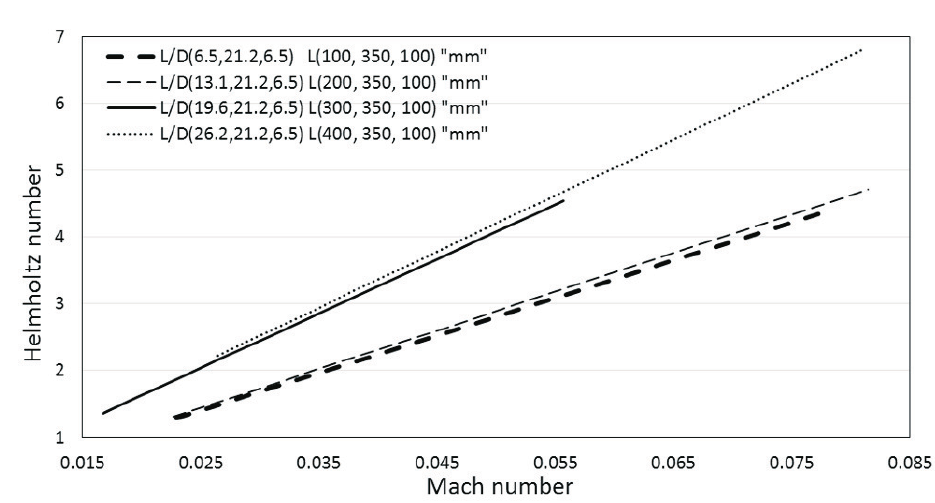
Figure 19. Helmholtz number He plotted against Mach number M for L up = 100–400 mm, L corr = 350 mm, and L dw = 100 mm.